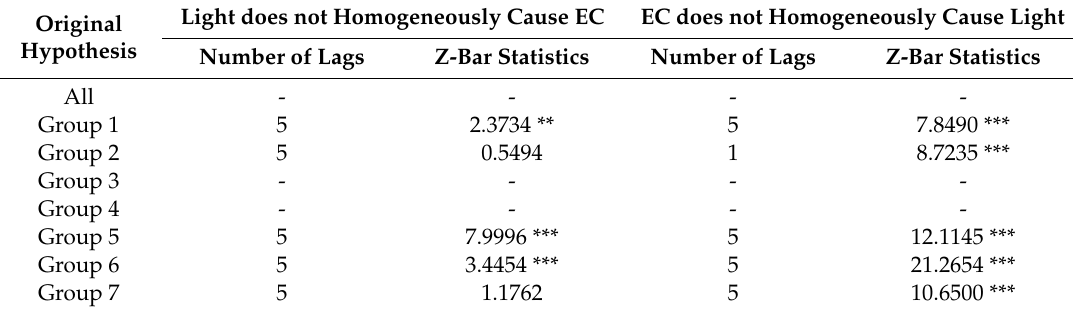
Table 8. Panel causality